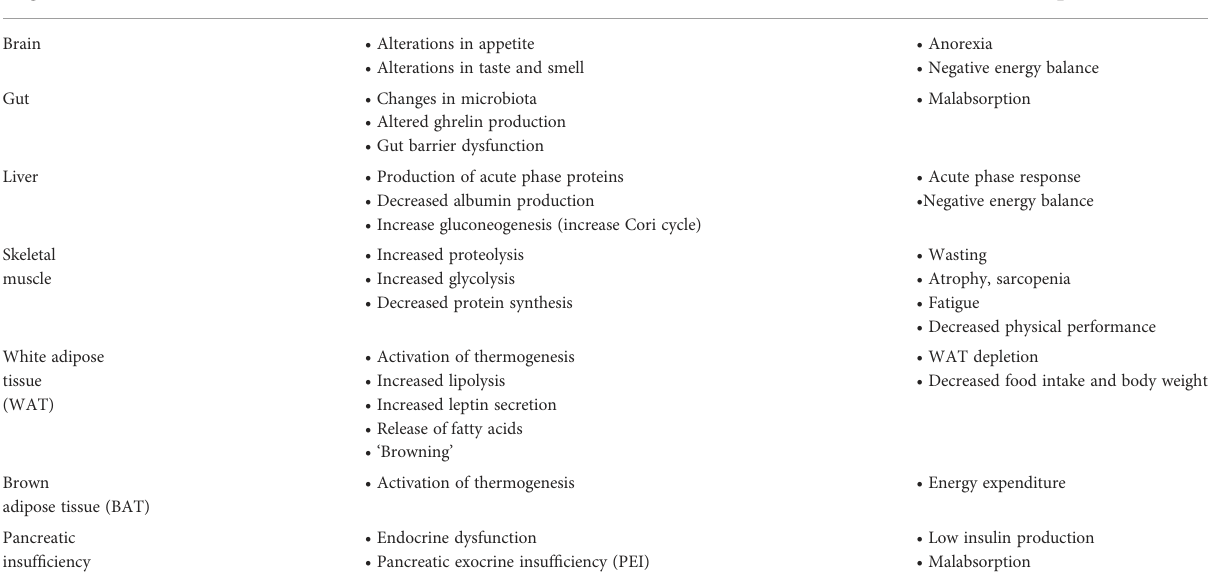
TABLE 3 The multi-organ response in PDAC-derived